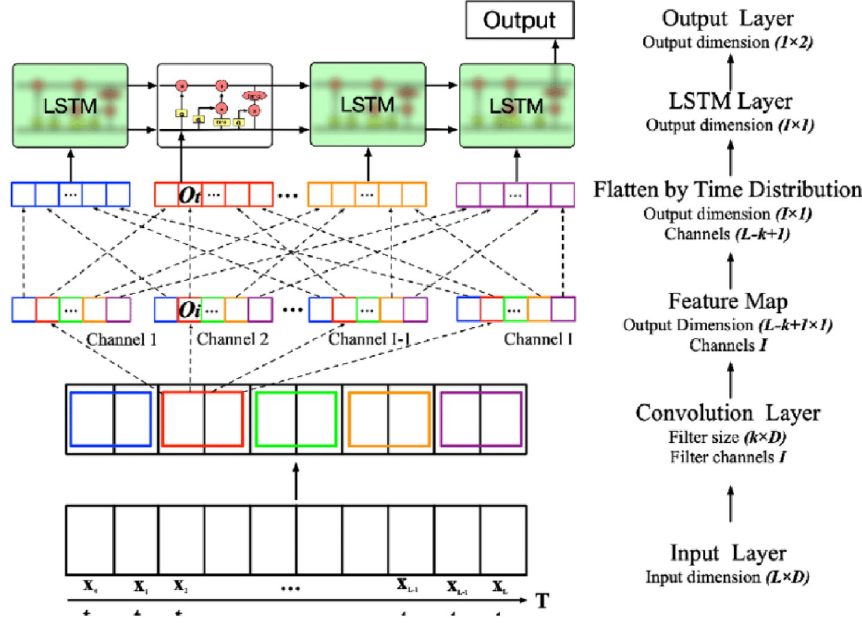
Fig 4. CNN-LSTM neural network